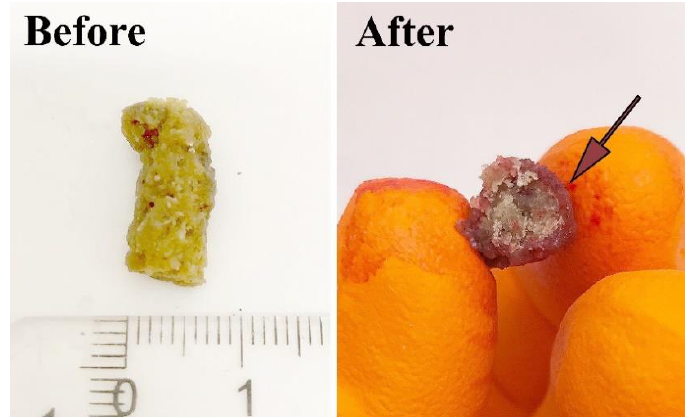
Figure 5. WG 5G5S LT before immersion in defibrinated sheep blood and a cut of the cross-section after 30 min immersion in the liquid.